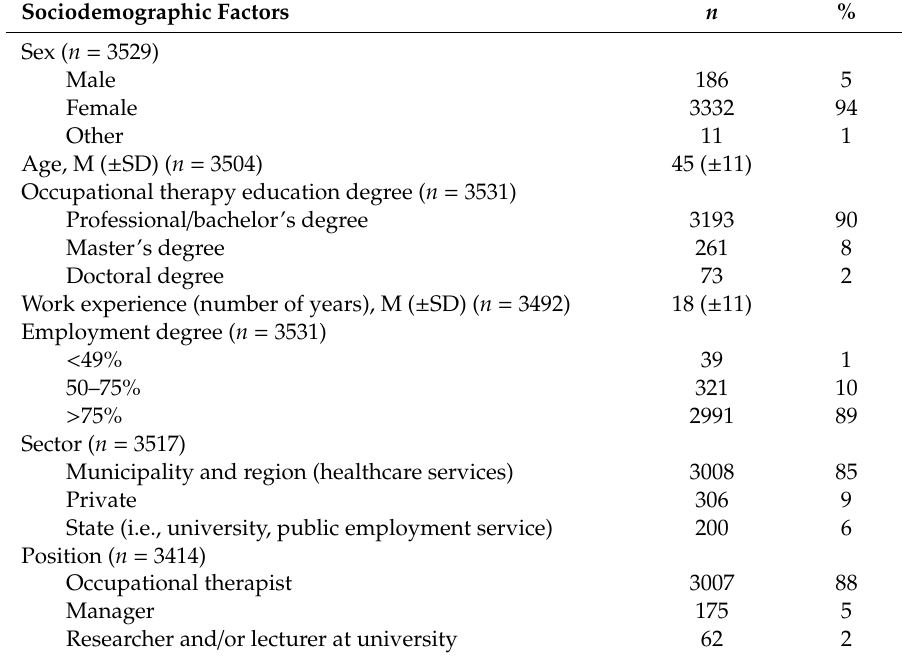
Table 2. Description of sociodemographic factors for occupational therapists participating in the web survey ( n =